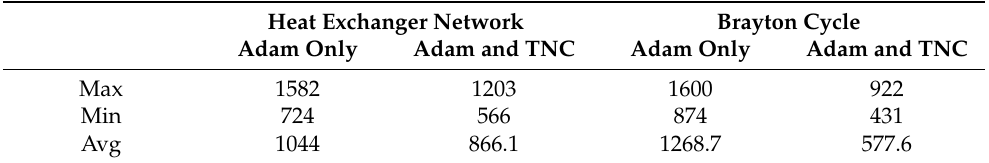
Figure 9. ( a ) Training history for the unsupervised training of the PINN model of the recuperated Brayton cycle using only the Adam optimizer; ( b ) Training history for the unsupervised training of the PINN model of the recuperated Brayton cycle using a combination of the Adam optimizer and the truncated Newton method. The various colors each represent a different sample of the same simulation. Table 10. Number of iterations for the various PINN models.